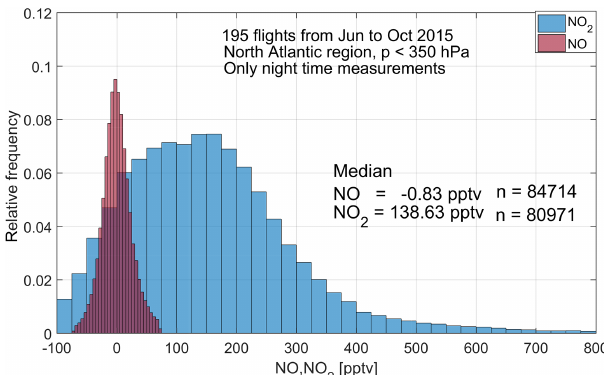
Figure 11. Relative frequency of nighttime NO and NO 2 measure- ments (4s) at cruising altitude ( p <350hPa) from 195 flights over the North Atlantic in 2015. The bin width is 25pptv for NO 2 and 5pptv for